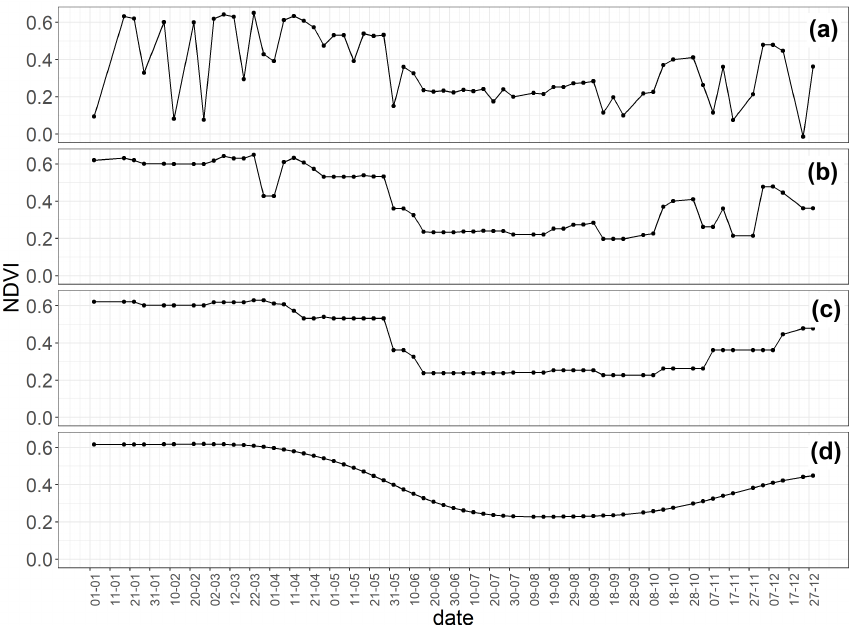
Figure 7. Stages of the NDVI time series trend construction for a cell: ( a ) the initial NDVI time series; ( b ) the series after filtration (1) with window width k = 3; ( c ) the series after averaging by the sliding median filter with window width k = 9; ( d ) the series after